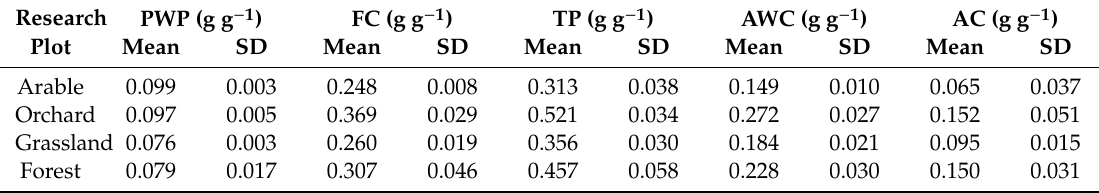
Table 3. Water retention properties of soils at the four research